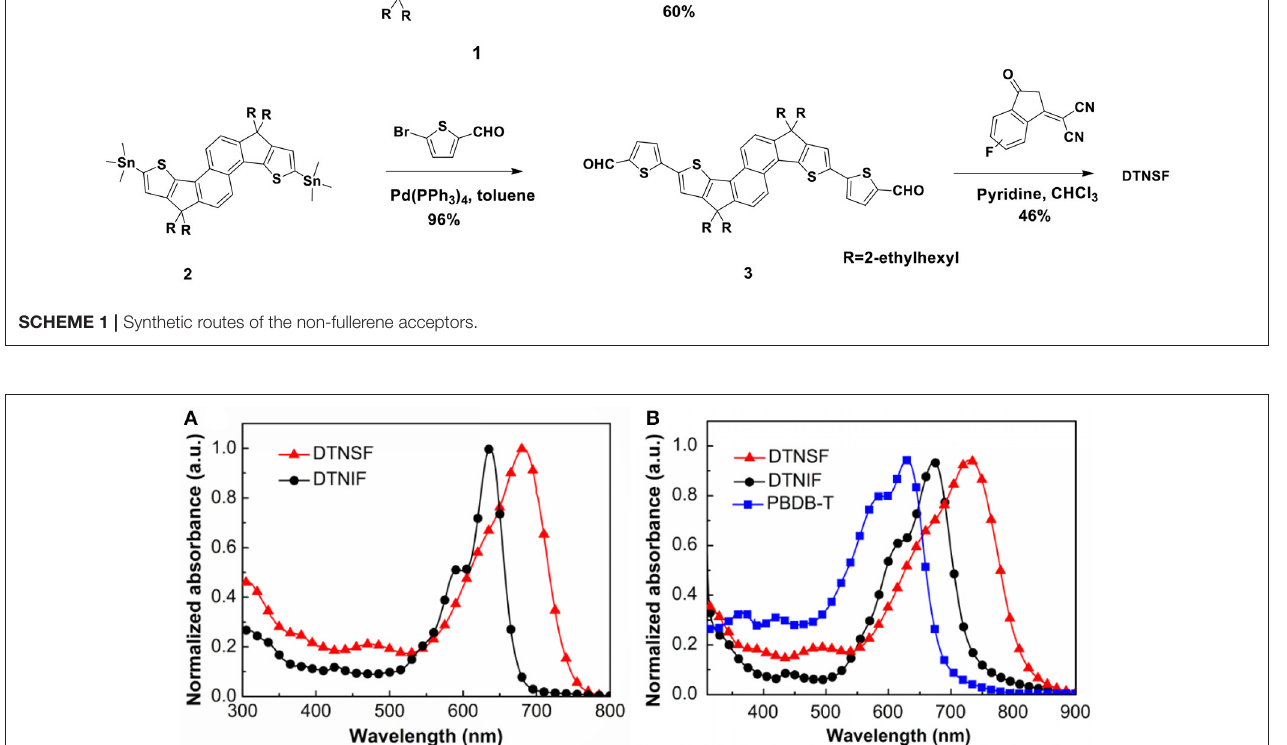
Frontiers in Chemistry | www.frontiersin.org